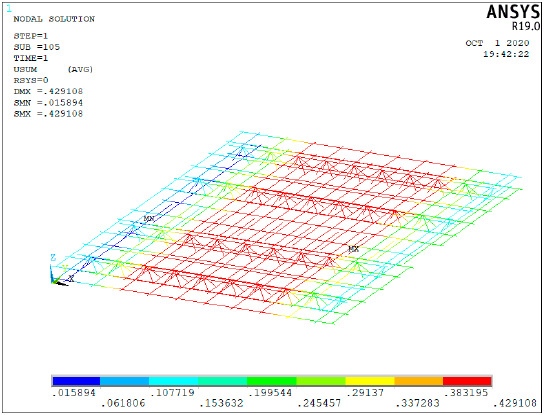
Figure 31. Deformation cloud map of reinforced grid under ultimate load.